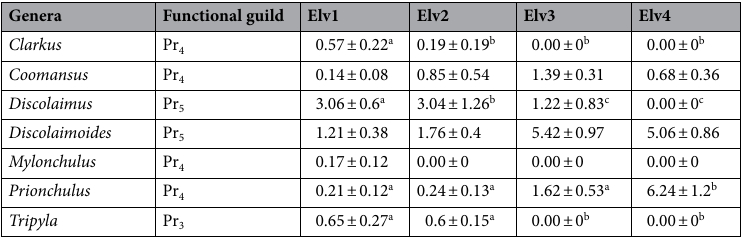
Table 1. Relative abundance of nematode genera in different elevation classes (mean ± standard error). Means (%) followed by different superscript letters are significantly different by the post hoc-test ( p < 0.05). Means followed by different superscript letters reflects significant differences. Bf: bacterial feeders, Ff: fungal feeders Hr: herbivores, Om: omnivores, Pr: predators and subscript 1–5 represent C–P scale.